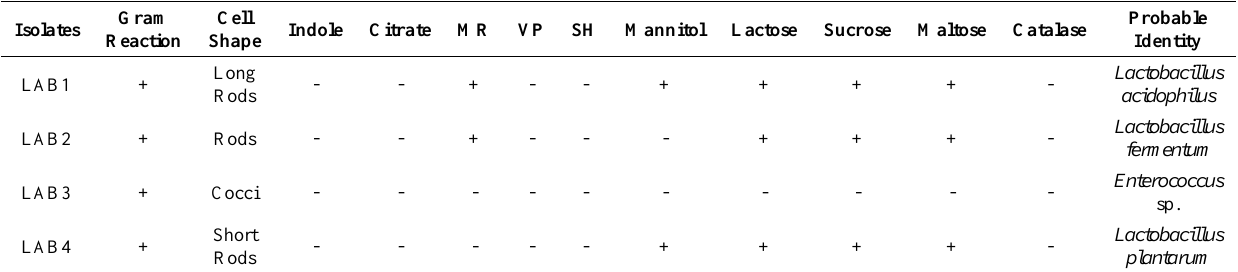
Table 1. Morphological and biochemical characteristics of the presumptive lactic acid bacteria (LAB) isolates